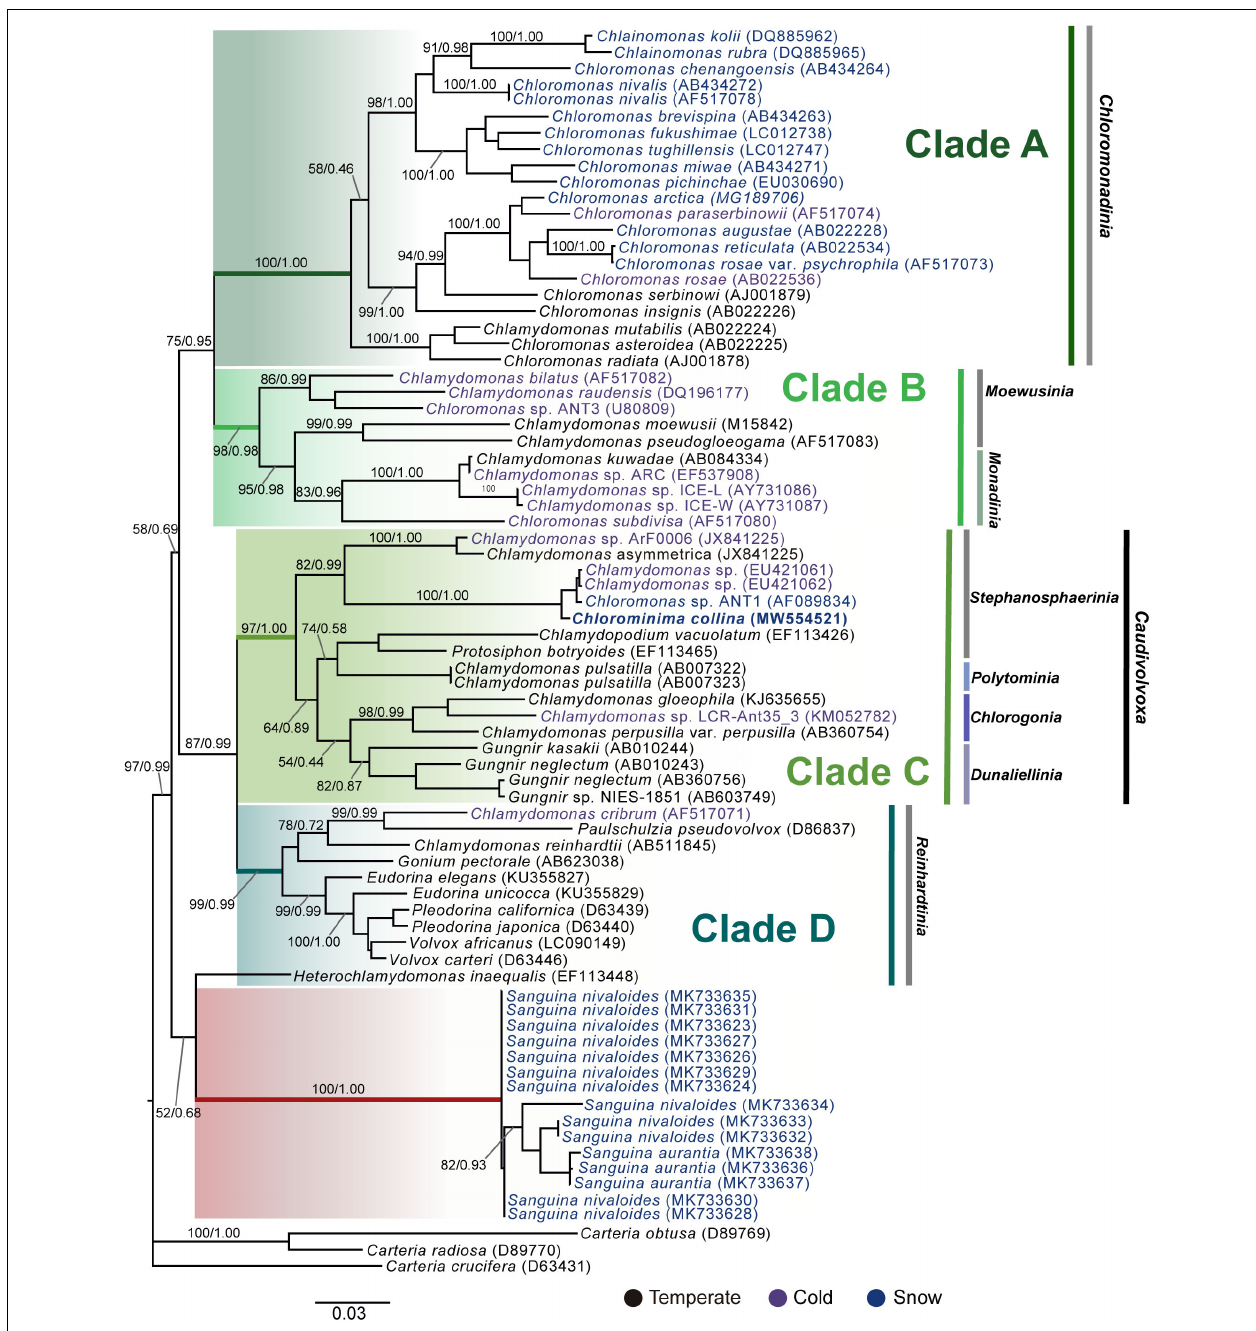
FIGURE 4 | Maximum-likelihood phylogram of rbcL gene sequences. The position of Chlorominima collina CCAP 6/1 and other related members of the order Chlamydomonadales. Clades A, B, C, and D were delimited according to Hoham et al. (2002). The names of the clades were designated according to Nakada et al. (2008). The new genus of Sanguina snow algae is specified (Procházková et al., 2019a). Representatives of the genus Carteria were used as outgroup. The numbers on the branches indicate statistical support values (Maximum-likelihood bootstraps/Bayesian posterior probabilities). Snow taxa are marked in blue, taxa from other cold environments, not from snow, are marked in purple and the rest of the taxa from other temperate environments are written in black. The lower bar indicates changes by nucleotide position